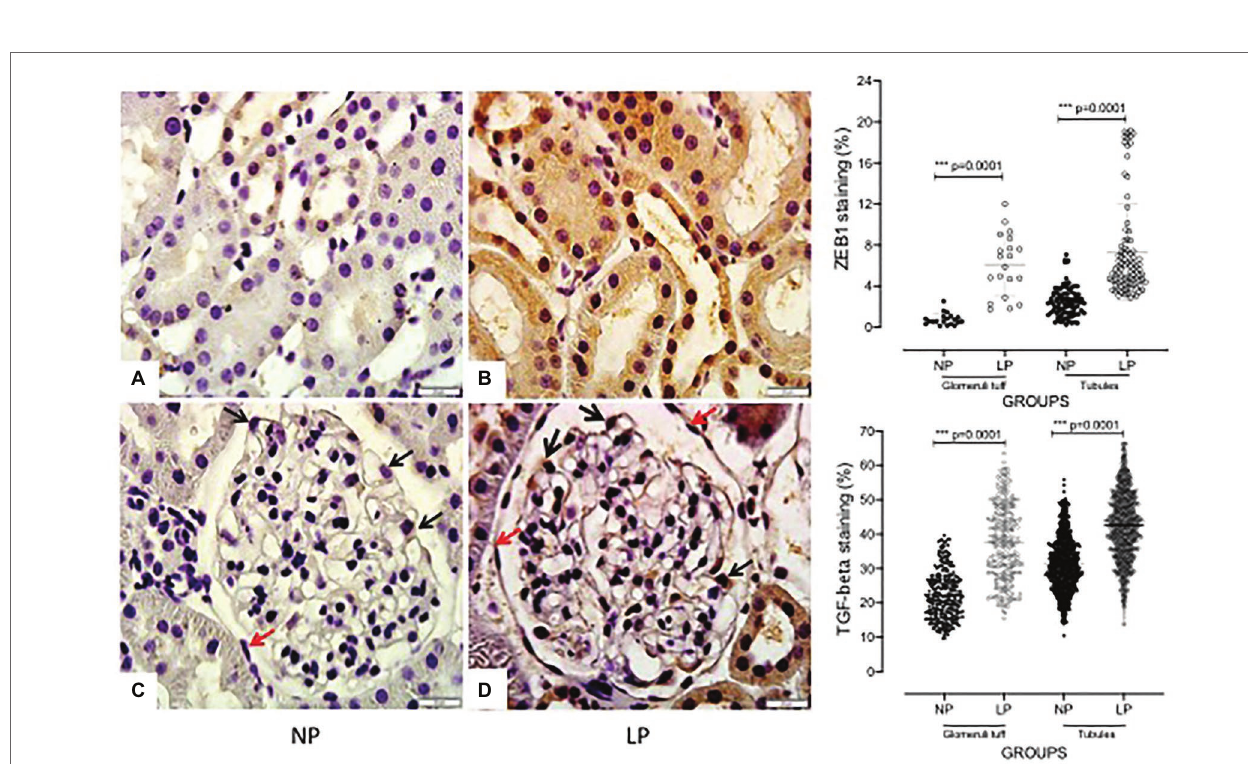
FIGURE 6 | Glomerular and tubular TGF β 1 and ZEB1 immunoperoxidase labeling in 24-week-old male NP offspring ( A/C ; n = 5) compared with age-matched LP progeny ( B/D ; n = 5). A red arrow indicates perivascular epithelial cell (PEC); a black arrow characterizes podocyte. A 400× and 1000× magnification was used in the tubular area (A,B) and glomerular area (C,D) , respectively. The scale bar can be found at the bottom right of each figure. Five cortical and medullar fields of each histological section were analyzed, and the average immunoreactivity reading was determined. Data are presented as scatter dot plots on the right; the unpaired Welch’ ANOVA test was used for data analysis. The level of significance was set at p <